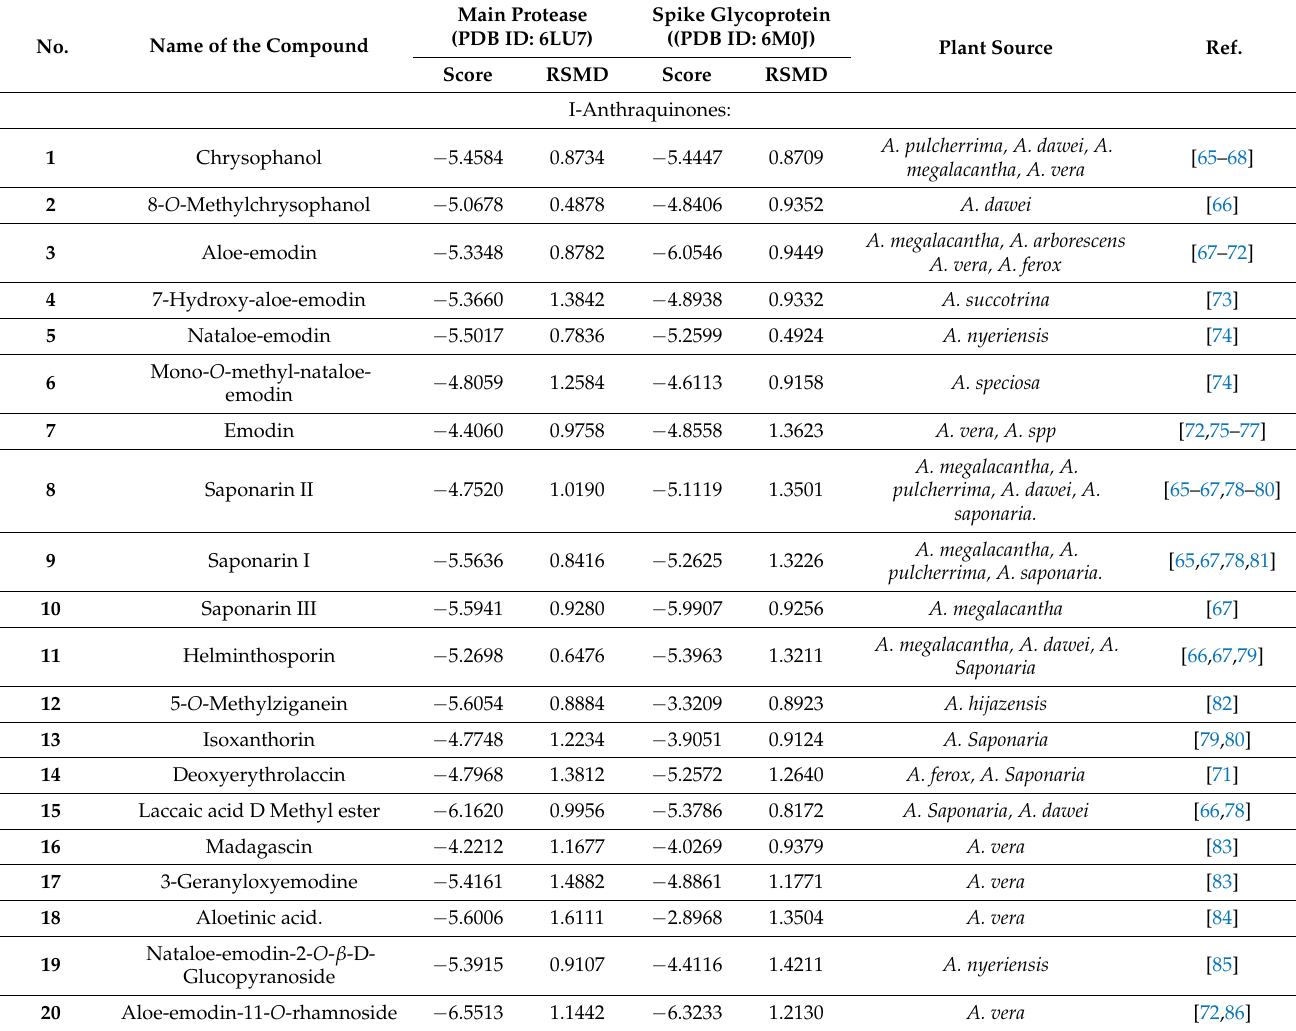
Table A1. Docking score of isolated compounds from Aloe plants against selected SARS CoV-2